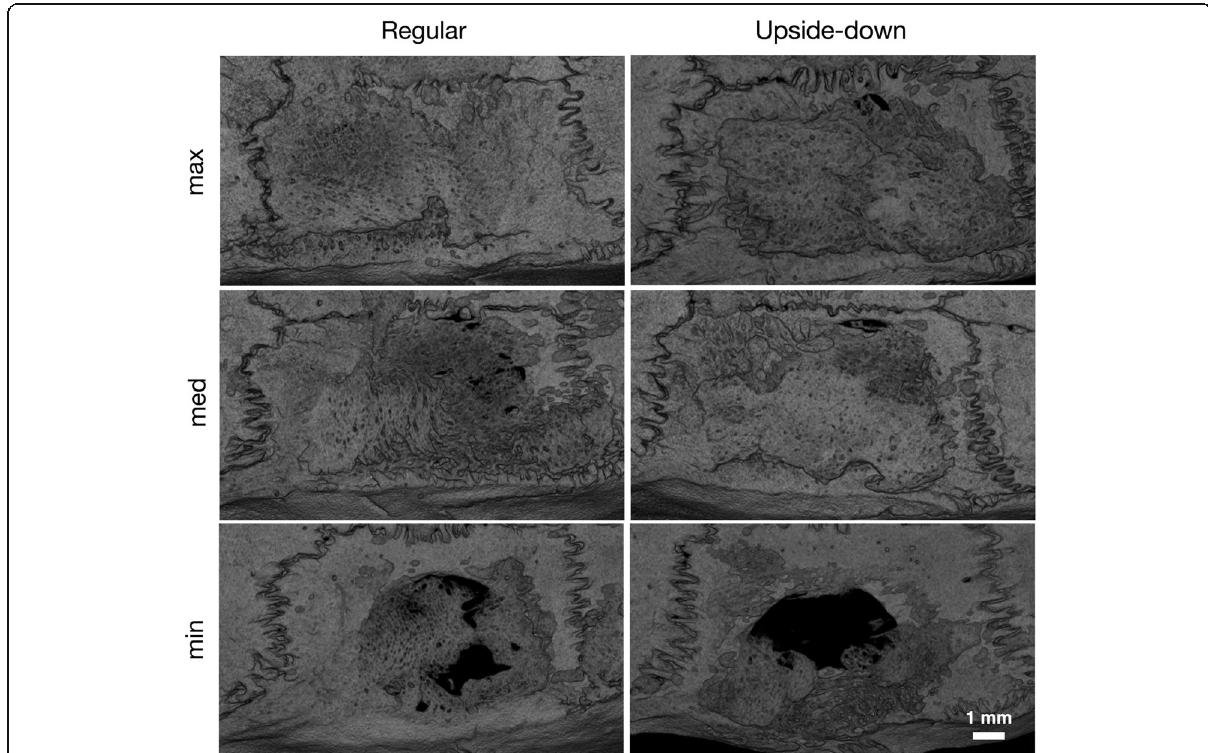
Fig. 2 Ex vivo μ CT overview of the calvarial defect anatomy after 4 weeks of healing. Critical size defects ( d = 5 mm) were covered using native resorbable bilayer collagen membranes placed regularly or upside-down. Representative samples of minimal, median, and maximal bone coverage of the defect in the respective groups are shown. Anterior is left. μ CT, micro-computed